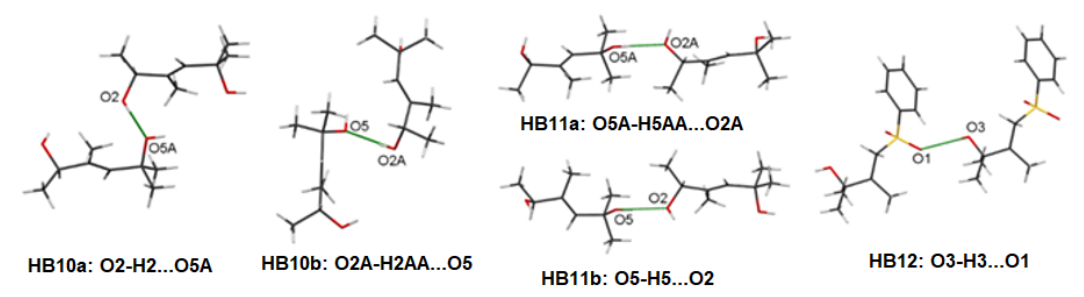
Figure 6. Selected hydrogen bond dimers found in precursors of the vitamin D analogue side chains.